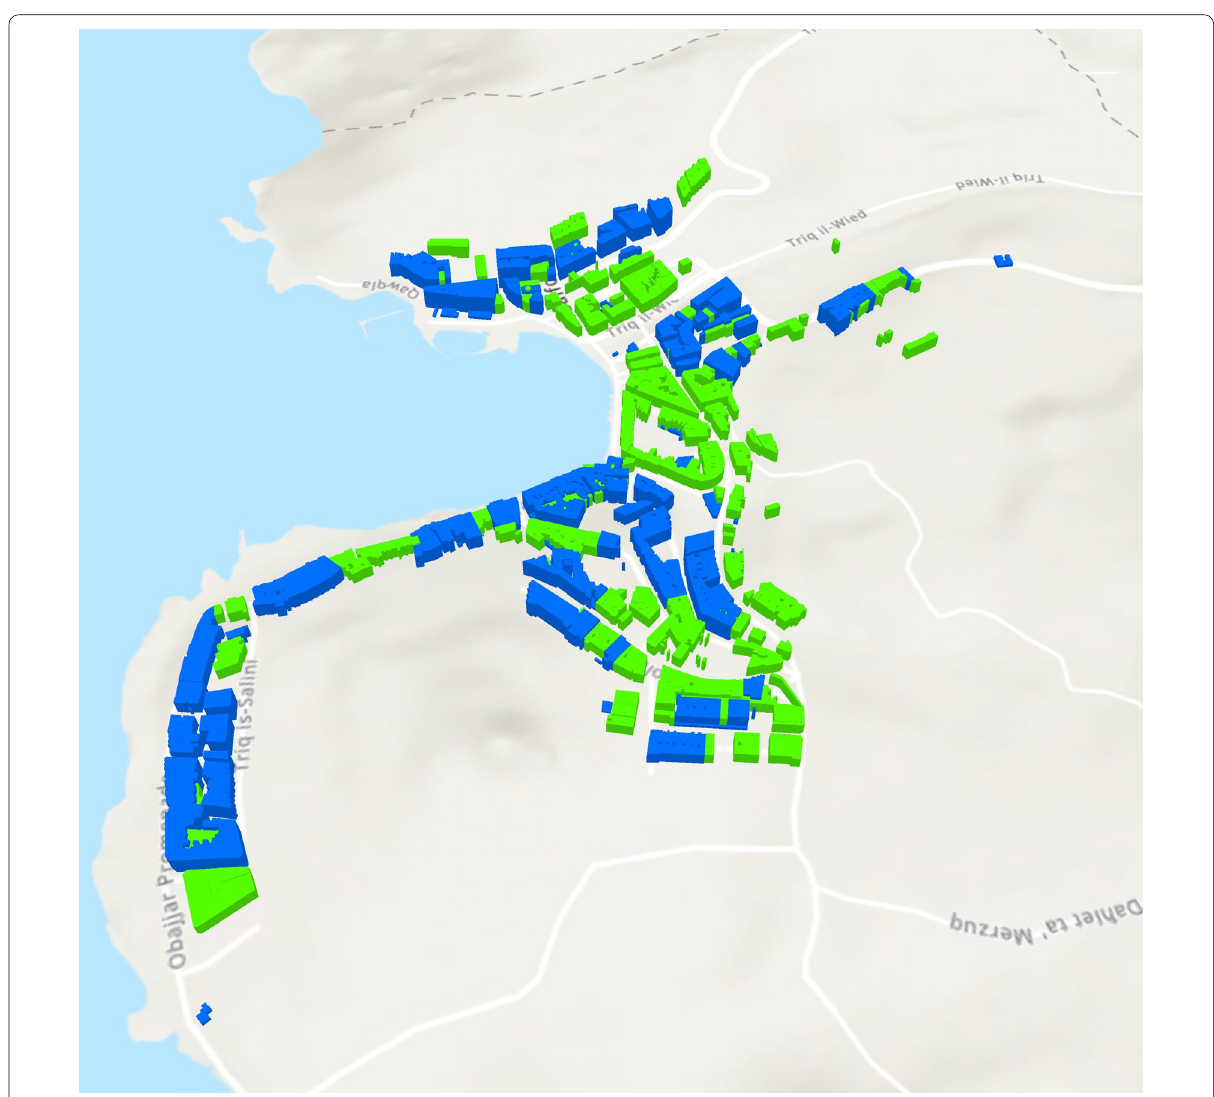
Fig. 5 Marsalforn: area inside buffer of 250 m—no infill (blue); area inside buffer of 250 m—infill